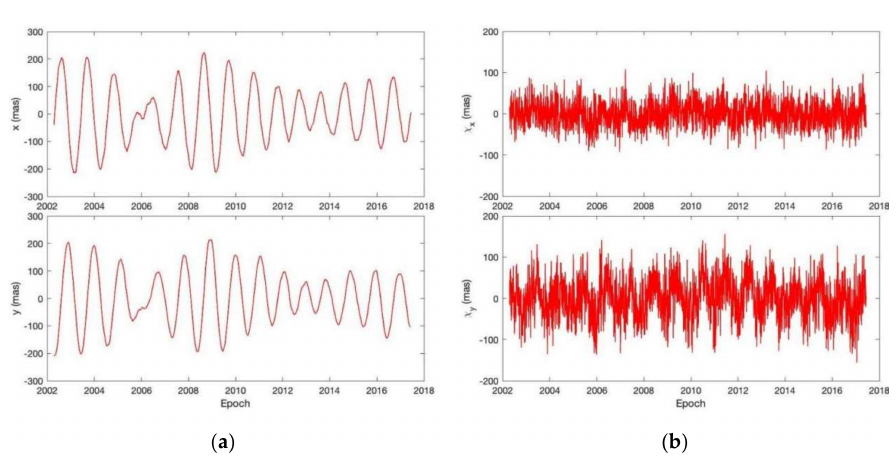
Figure 1. Time series for the observed PM and the geodetic excitation. ( a ) The x- and y-components of PM; ( b ) the x- and y-components of the geodetic excitation derived from the observed PM using Equation